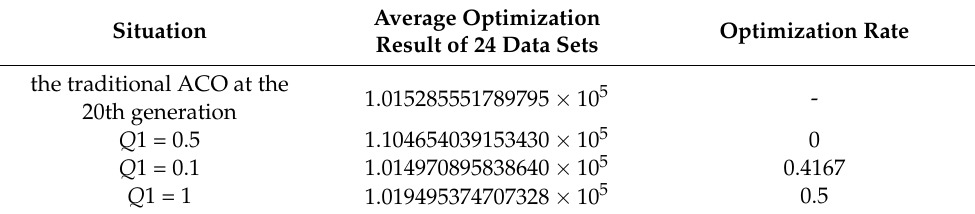
Table 3. The test results of qualitative prediction